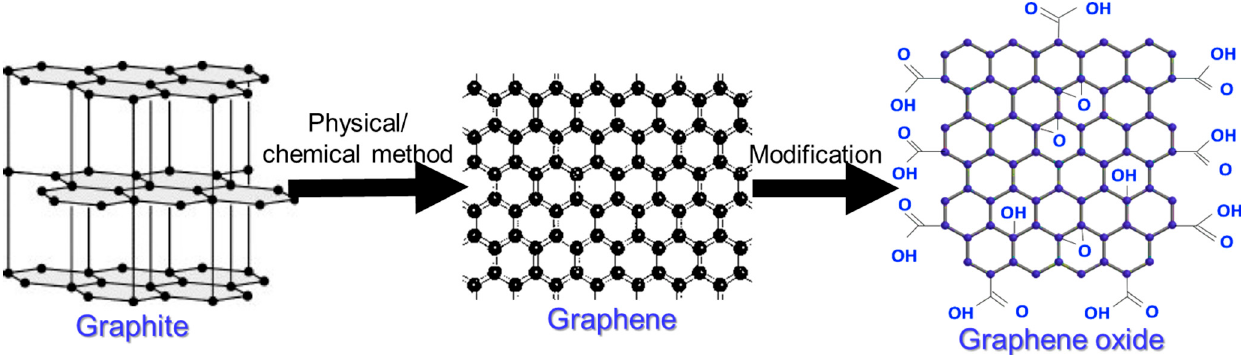
Figure 1. Graphene and modification.